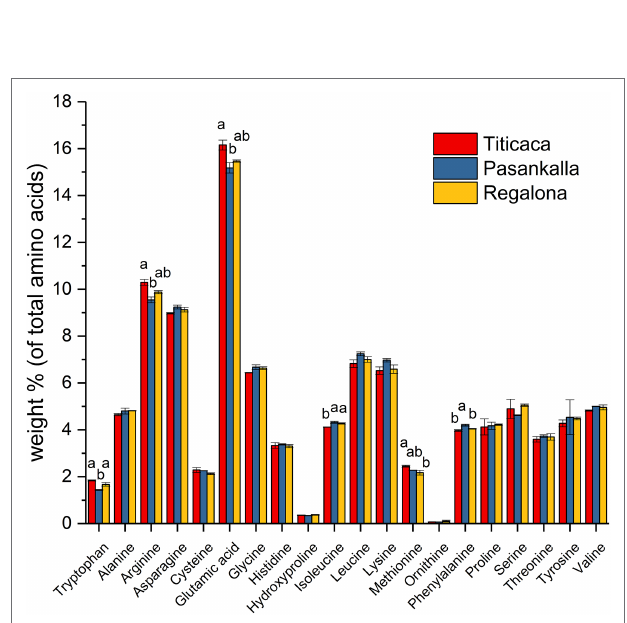
FIGURE 4 | Amino acid profile in mature quinoa seeds of Titicaca, Pasankalla, and Regalona. Results are showing mean values ± SD of two biological replicates. Bars for amino acids showing significant differences between genotypes are marked with letters. Bars that do not share a letter are significantly different according to Tukey’s test ( p ≤